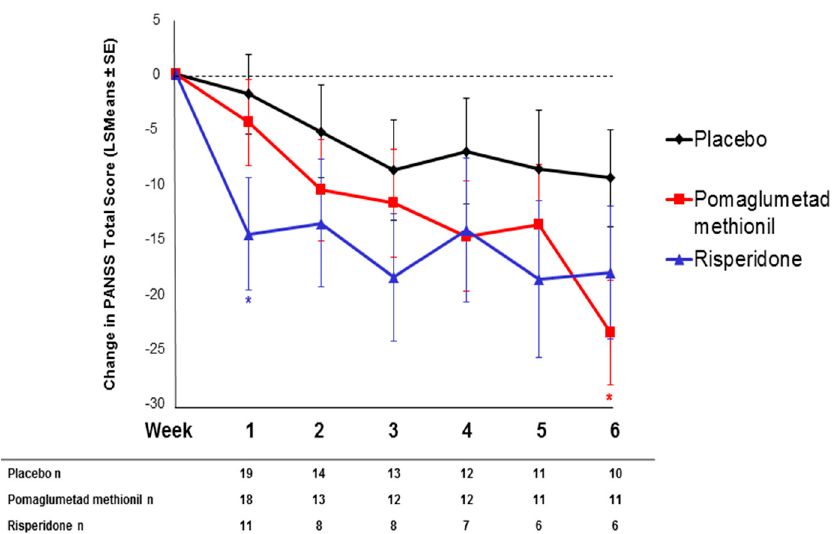
Figure 5. Change in PANSS total score in Caucasian T/T homozygous patients treated with pomaglumetad methionil 40 mg BID, risperidone 2 mg/day or placebo. Abbreviations: BID = twice daily; n = number of patients with PANSS measures; LSMeans = least squares means; PANSS = Positive and Negative Syndrome Scale; SE = standard error. * p ≤ 0.05, two-sided p -value.